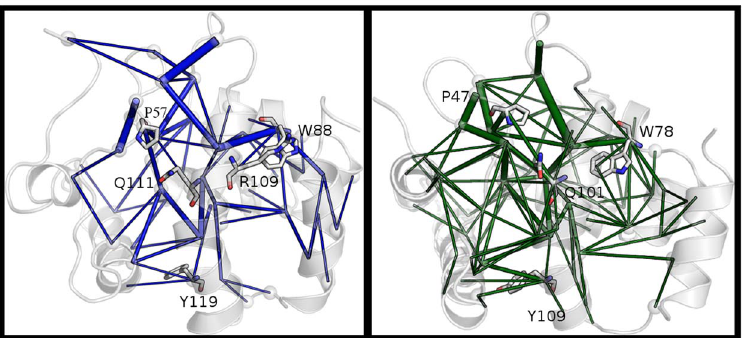
Figure 6. Shortest paths of long-range communication in ARID3A and Dri. The edges which are present with highest probability in the paths of long-range communication identified by PSN-LMI approach are indicated for ARID3A FREE (blue) and Dri FREE (dark green) simulations by lines of thickness proportional to the occurrence probability. The residues connected by the edges are indicated as spheres, whereas the residues known to compromise the DNA-binding capabilities in ARID3A, along with Q111/Q101 and R109/R99 are shown as sticks if identified in the